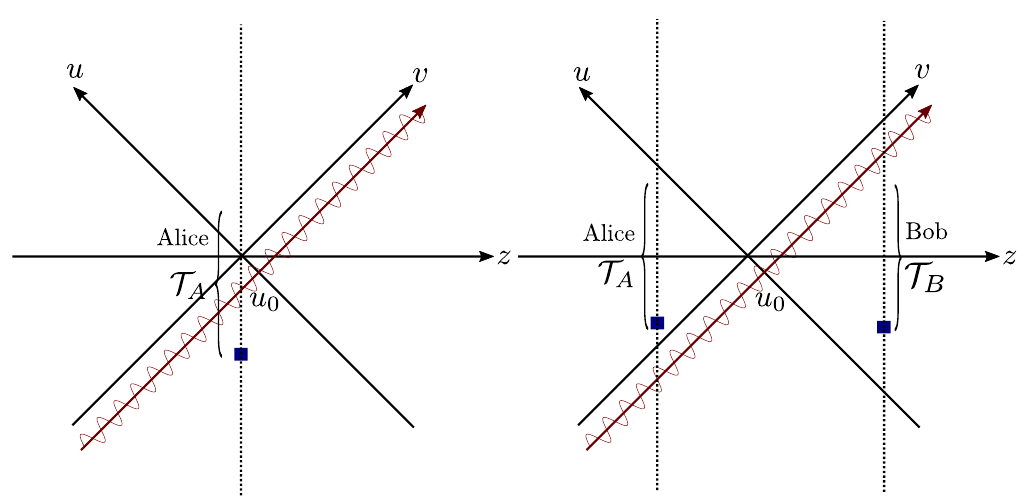
Figure 1 . Single detector and entanglement harvesting protocol. Left: Alice and her detector cross the shockwave whilst interacting with the field for time T A . (For example, T A could correspond to the interval [ − 4 T + τ 0 , 4 T + τ 0 ] around the peak of the Gaussian switching (4.3).) Right. Alice and Bob are located on either side of the shockwave and never cross the shockwave while interacting with the field for a duration T . This interaction leads to entanglement between A/B Alice and